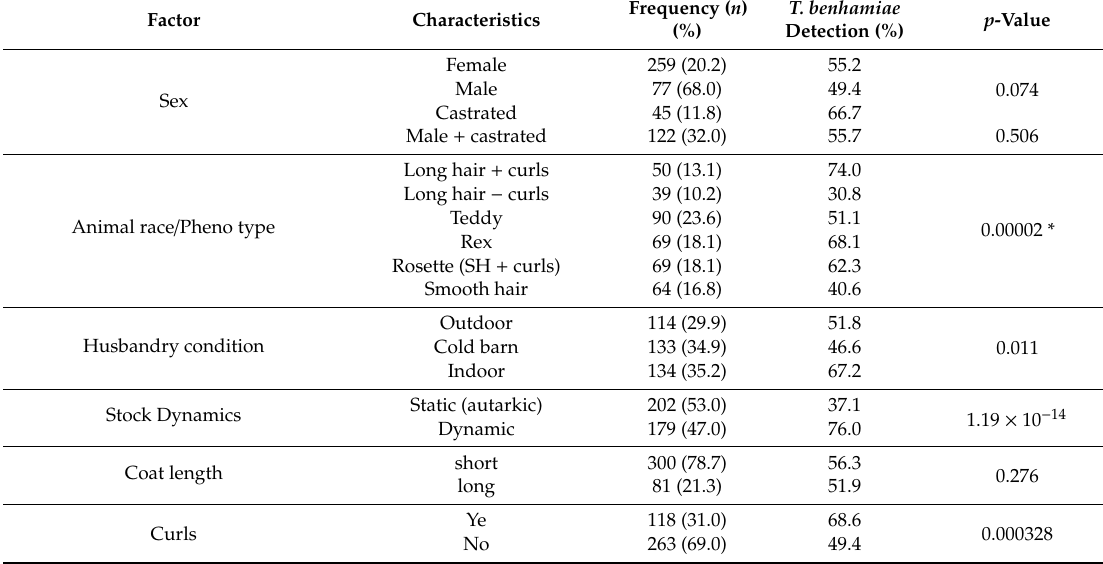
Table 2. Description of possible risk factors, their observed frequency, and their influence on the detection of T. benhamiae (SH—shorthair). * Comparison between all animal